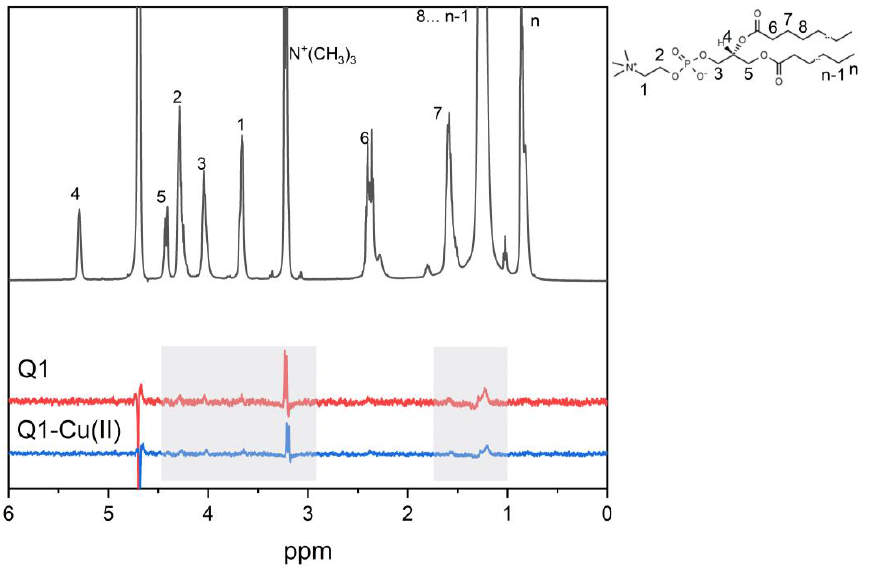
Figure 5. 1D NOESY spectra of Q1 (red line) and the Q1 − Cu(II) complex (blue line) and 1 H NMR spectra (gray line) of Q1 in DMPC/DHPC bicelles. pH = 4. Q1 concentration was 1 mM.